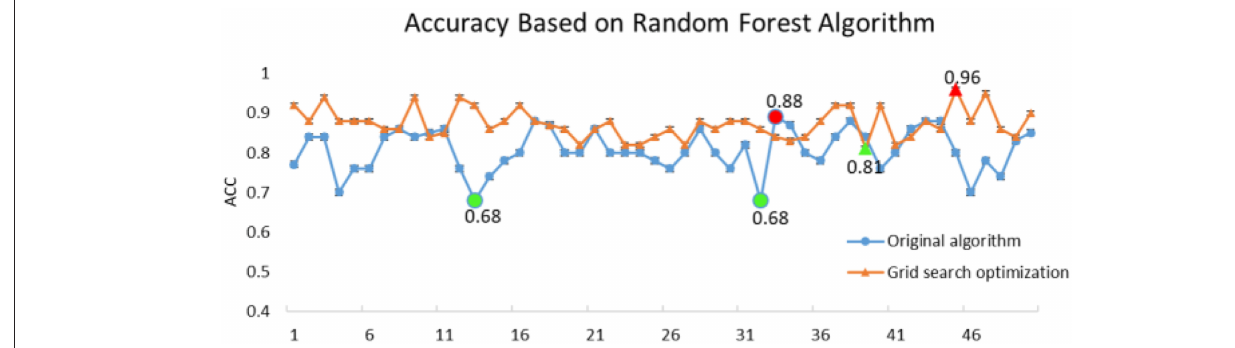
FIGURE 4 | Comparison of execution accuracy between RF and RF-GSO.